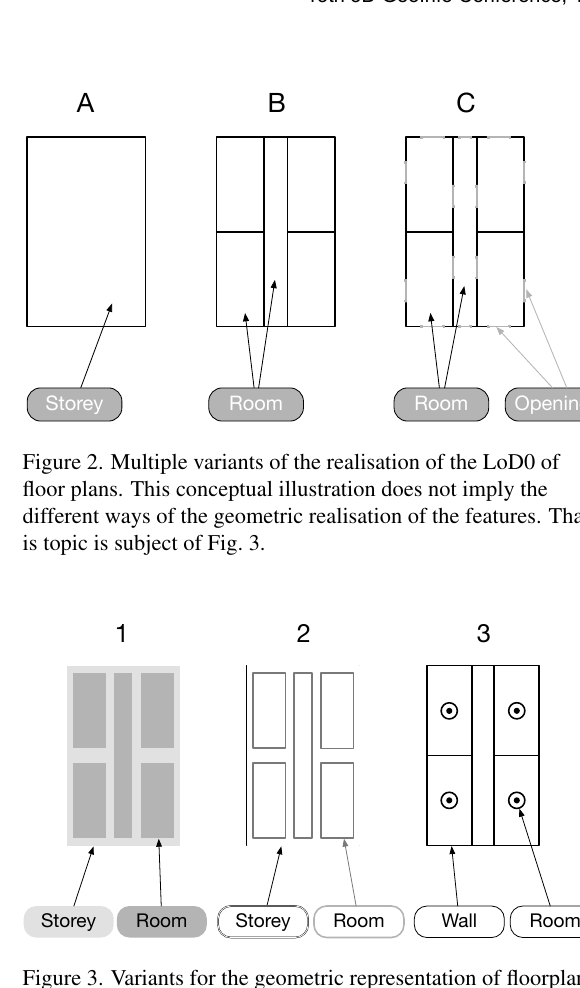
Figure 3. Variants for the geometric representation of floorplan features. This illustration does not imply presence or absence of specific features. For each variant, rooms could be removed or openings could be added (Fig. 2).